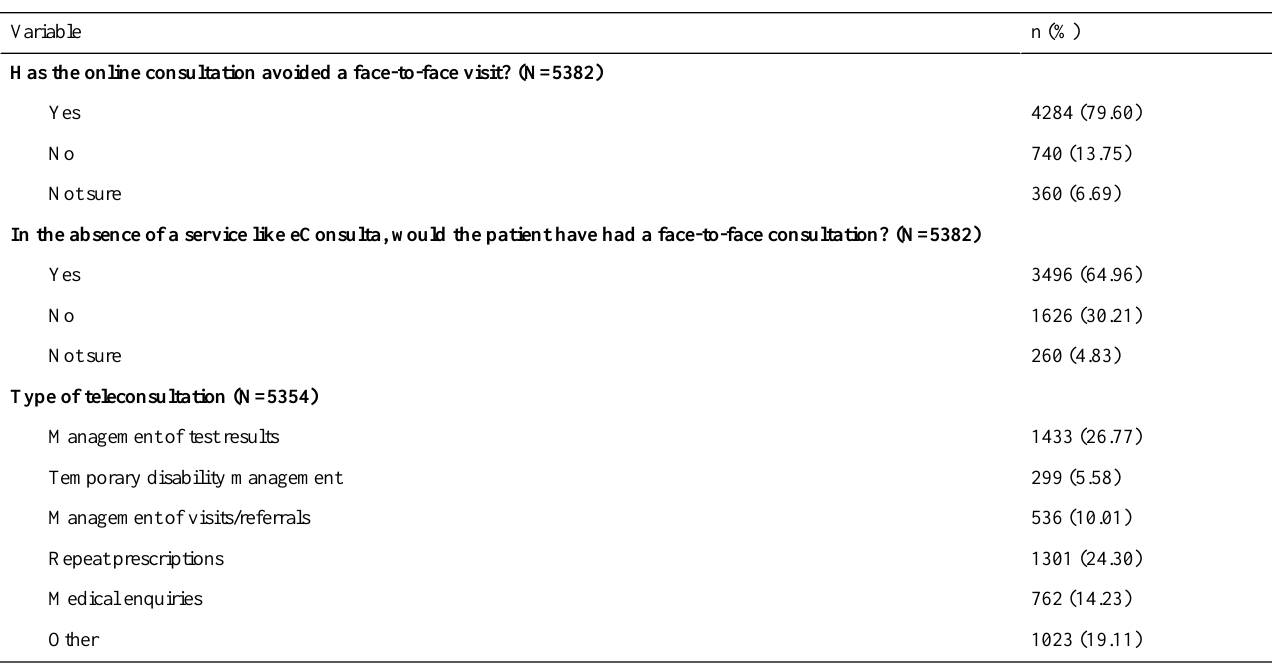
Table 1. Results of the annotation.